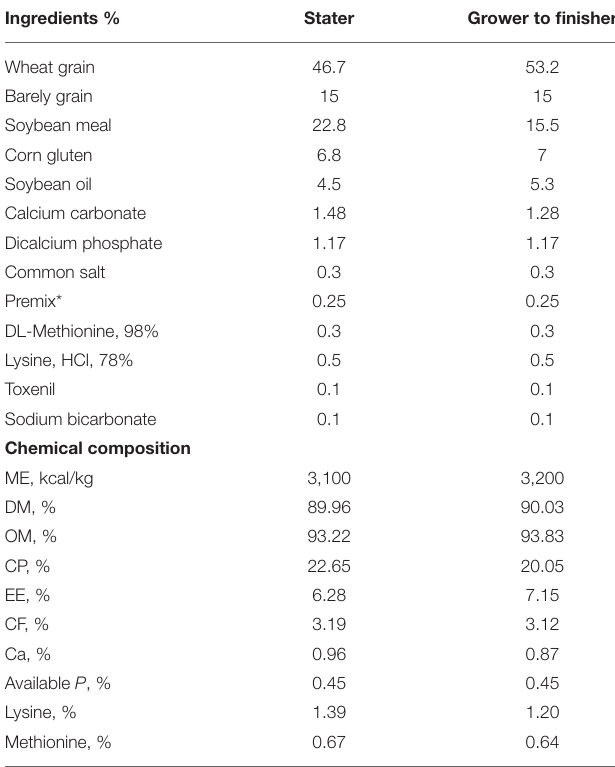
TABLE 1 | Ingredients and chemical composition of the basal diets (as